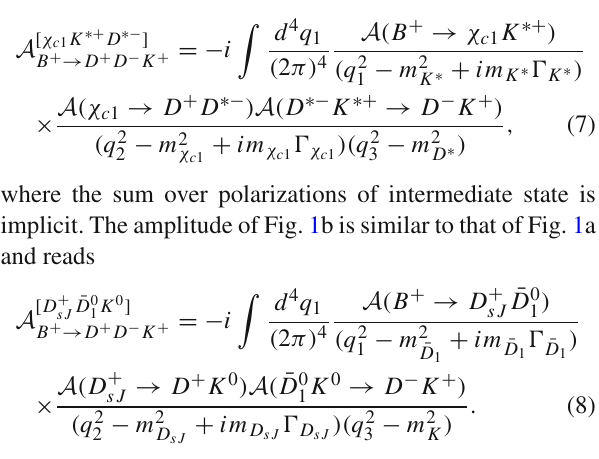
¯ D 0 K 0 → D − K + , we employ the heavy [22]. For 1